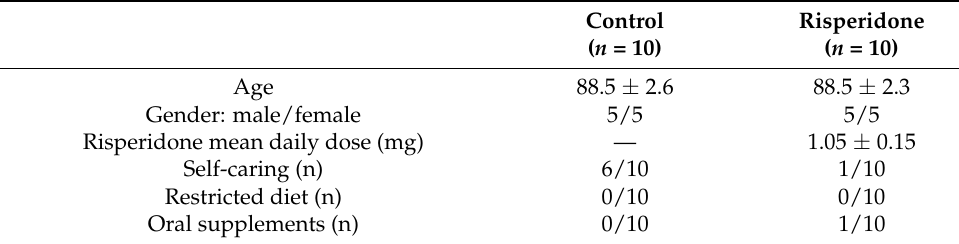
Table 1. Characteristics of study